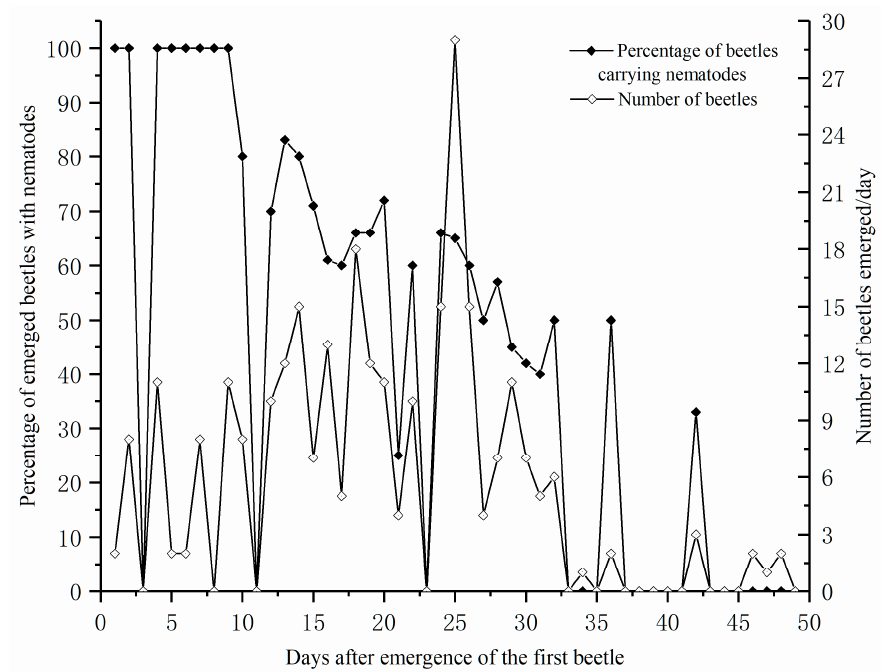
Figure 1. The percentage of beetles carrying nematodes ( ◆ ) and the emergence of Monochamus saltuarius from pine timbers ( ◇ ) during the emergence period in 2018.